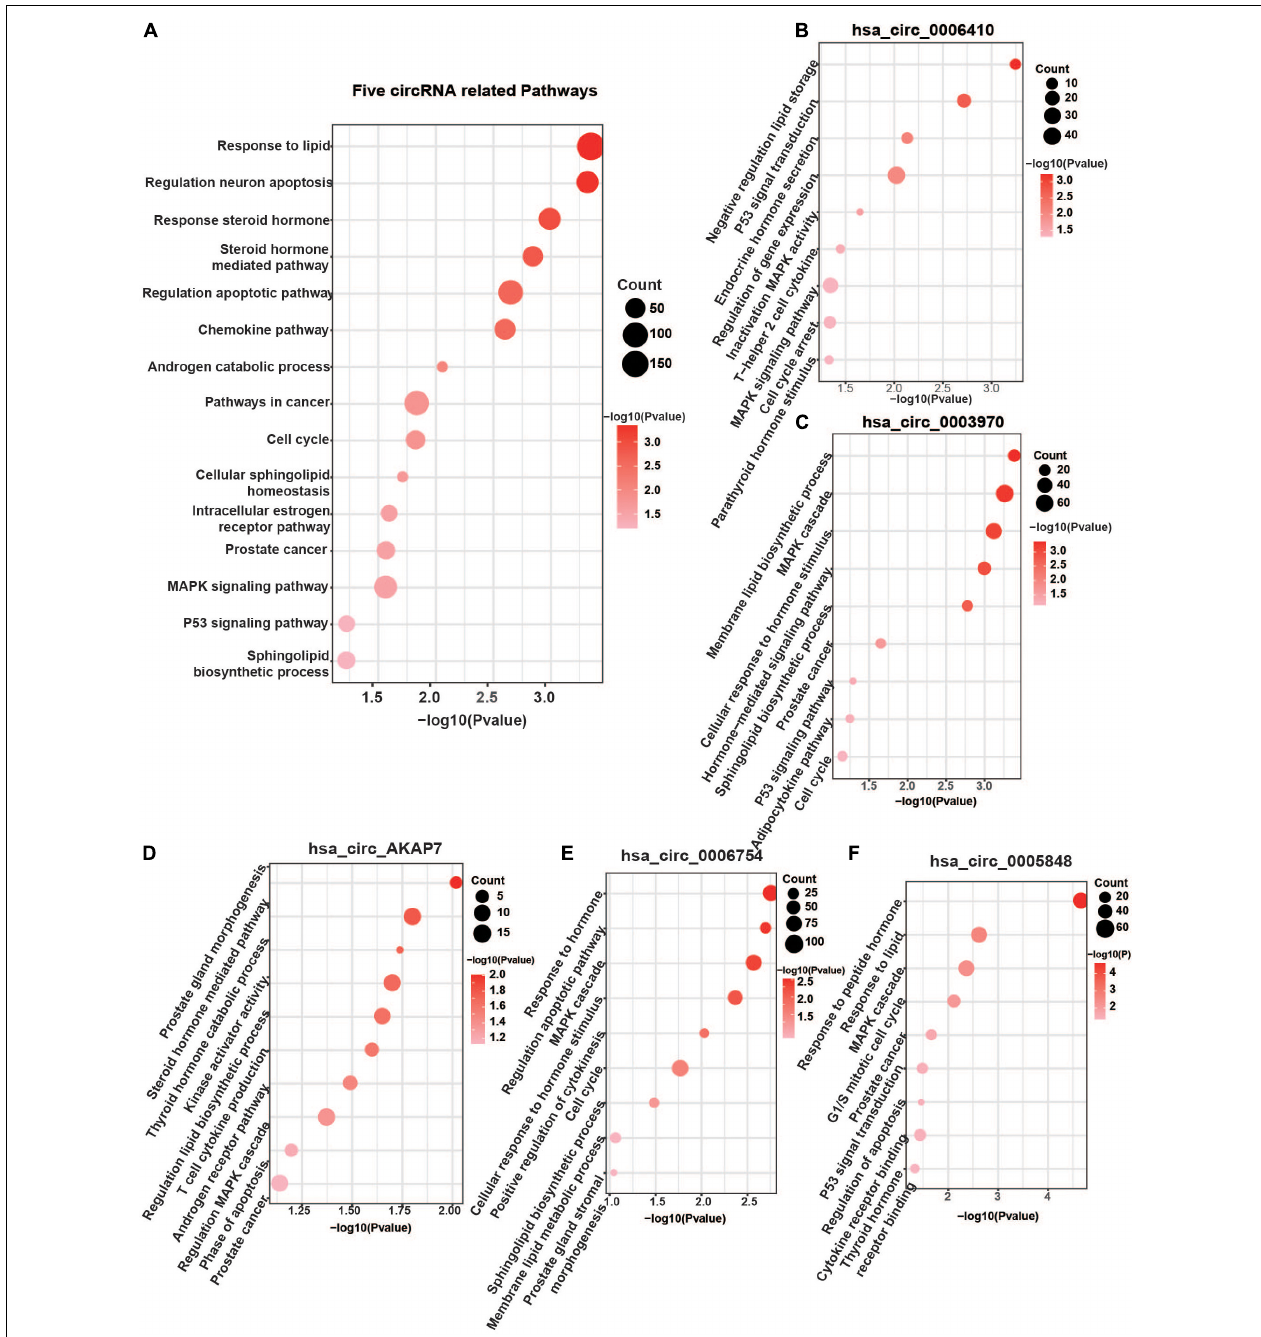
FIGURE 4 | Five specific circRNA-related pathways. (A) The five circRNA-related pathways. Only differentially expressed mRNAs with prediction score higher than 90 were considered. Well-known PCa-related pathways, such as the MAPK signaling pathway, P53 pathway, AR pathway, cell cycle, steroid hormone-mediated signaling pathway, and lipid-related process, were all found. (B) hsa_circ_0006410 related pathways. (C) hsa_circ_0003970 related pathways. (D) hsa_circ_AKAP7 related pathways. (E) hsa_circ_0006754 related pathways. (F) hsa_circ_0005848 related pathways. “Count” represents the number of genes in the relevant